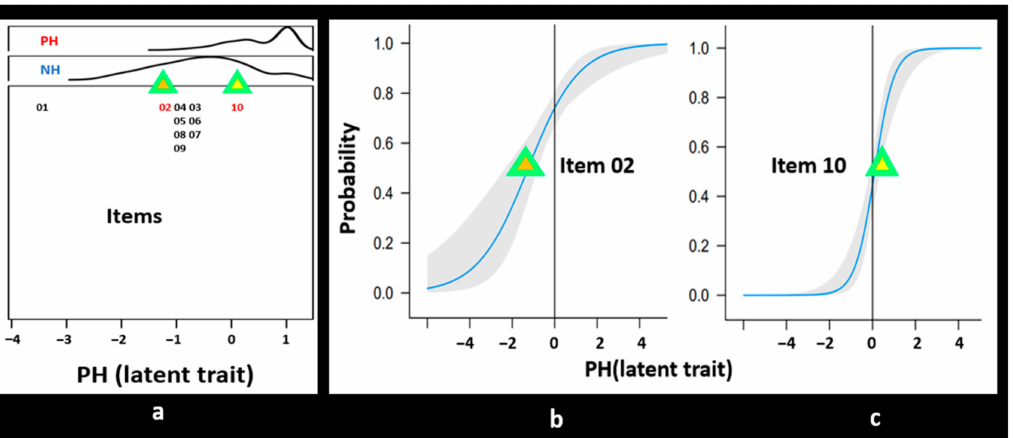
Figure 3. IRT output. ( a ) Wrightmap of 10 items that measure PH (based on simulated data). Both participants (divided in PH and NH groups) and items are located on the latent trait of PH. ( b ) Item Characteristic Curve of item 02 “Doing something sexual helps me cope with stress“. ( c ) Item Characteristic Curve of item 10 “My sexual appetite has gotten in the way of my relationships“. A short tutorial on IRT analyses based on these data can be found in the Supplemental Material File